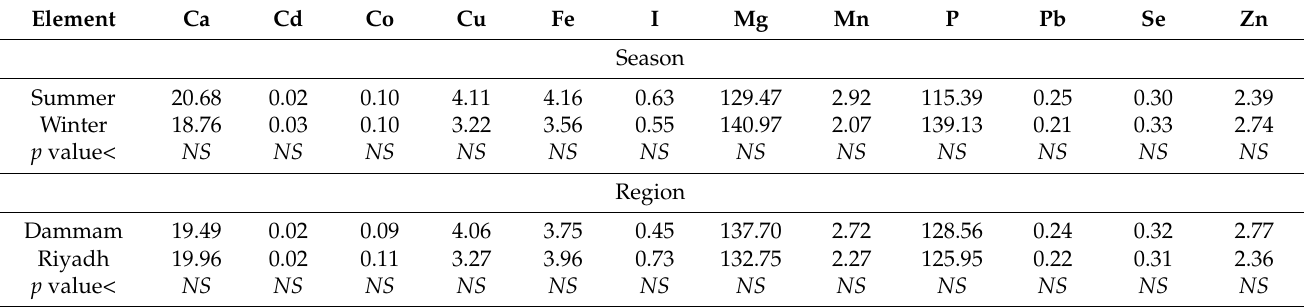
Table 8. Mean values of minerals in camel rumen fluid according to region and season [in µ g/L].